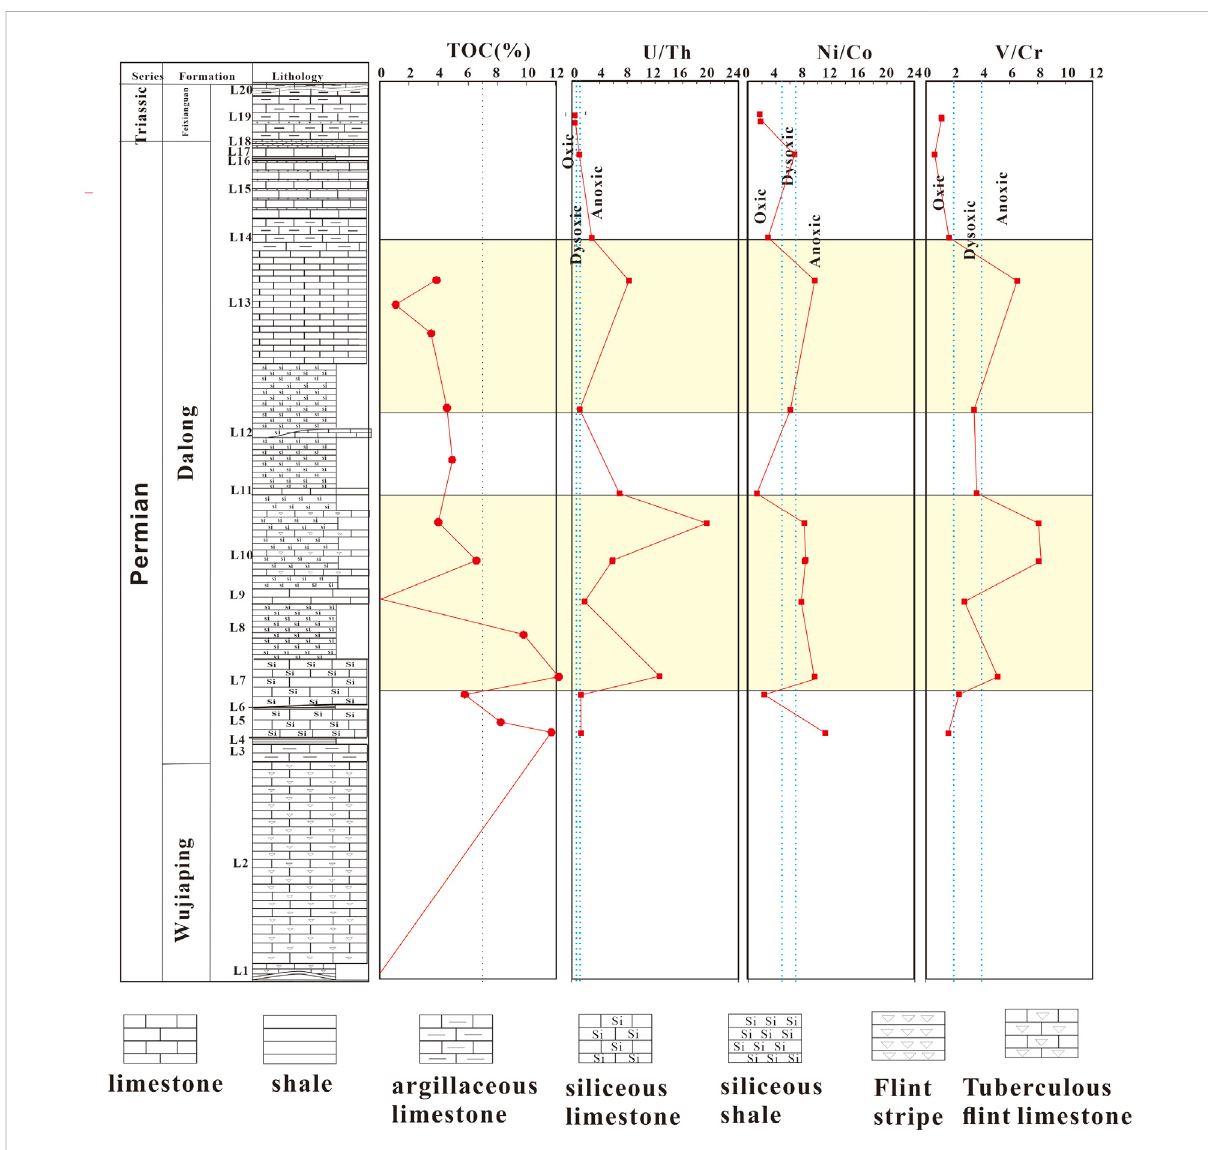
FIGURE 7 Variation in TOC, Ni/Co, V/Cr, and U/Th ratios of samples taken in Longfeng Quarry in Northwest Township,